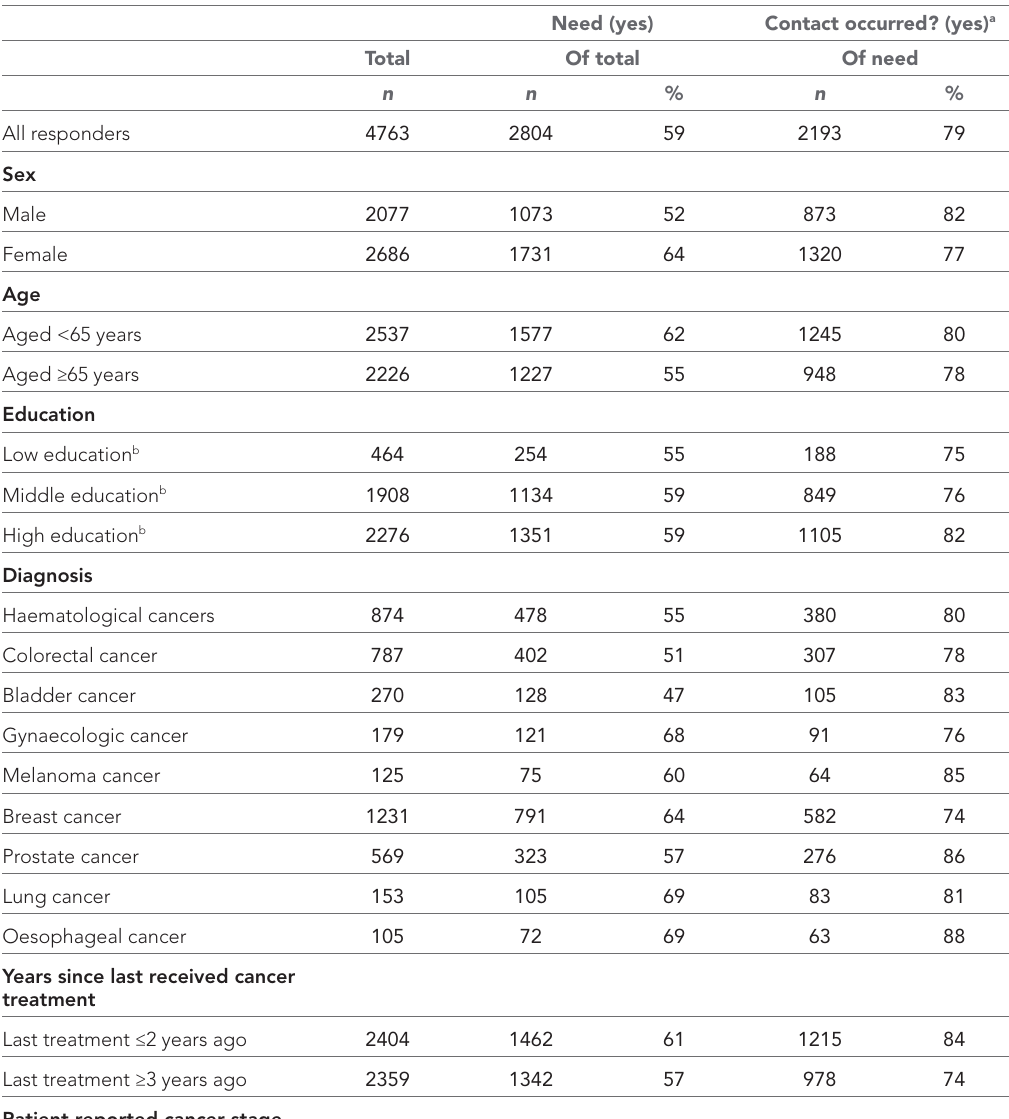
Table 2 Need for GP involvement in cancer care and whether GP involvement occurred. Presented for total and stratified per subgroup Need for GP involvement in cancer care any time after diagnosis Need